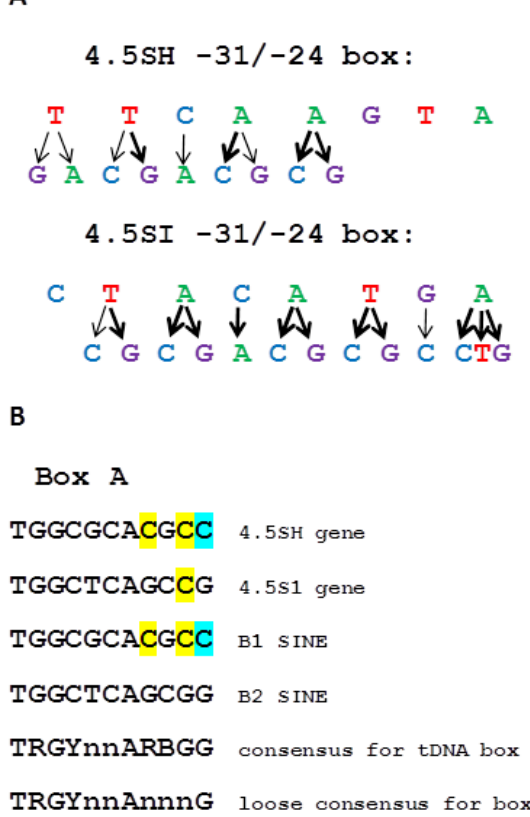
Figure 12. ( A ) Nucleotide sequences of − 31 / − 24 boxes of murine 4.5SH RNA and 4.5SI RNA ( Mmu1 (cid:48) ) genes. The nucleotide substitutions leading to strong or moderate reduction of pol III transcription of these genes are indicated by thick and thin arrows, respectively. ( B ) Comparison of box A nucleotide sequences from murine 4.5SH RNA and 4.5SI RNA ( Mmu1 (cid:48) ) genes, as well as B1 and B2 SINEs with box A consensus sequences from tRNA genes and SINEs. The nucleotides di ff ering from those in box A consensus sequence of tRNA genes are highlighted [12,53]. The C residue, which does not correspond even to the loose consensus sequence of box A, is marked in blue.